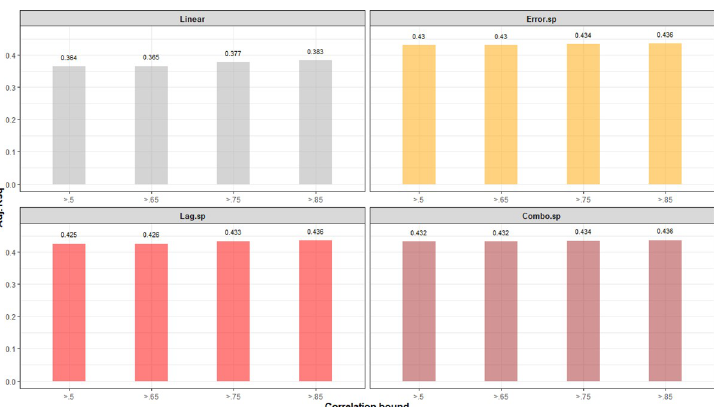
Fig 8. Sensitivity of adjusted R 2 to Spearman correlation threshold used in variable